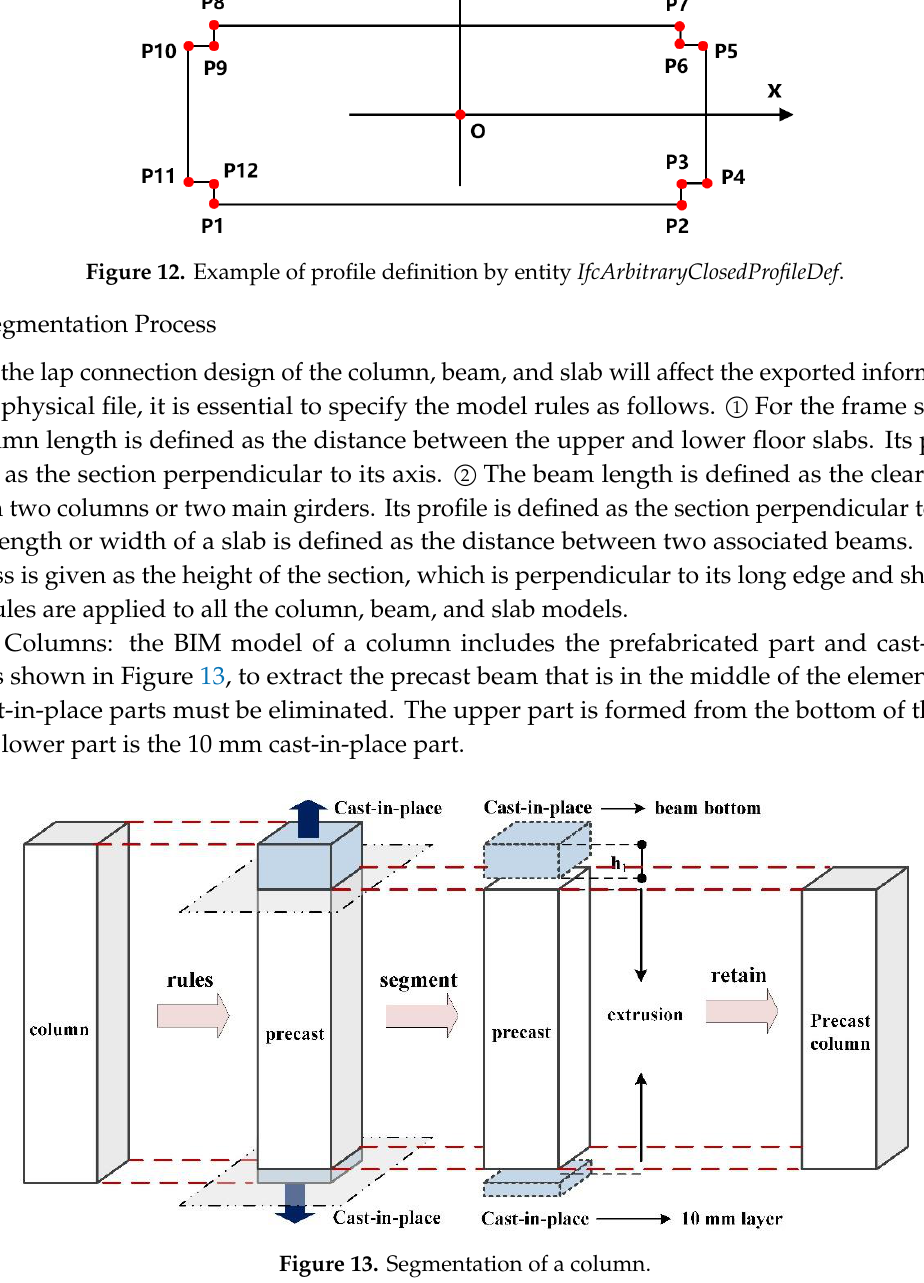
Figure 13. Segmentation of a column.